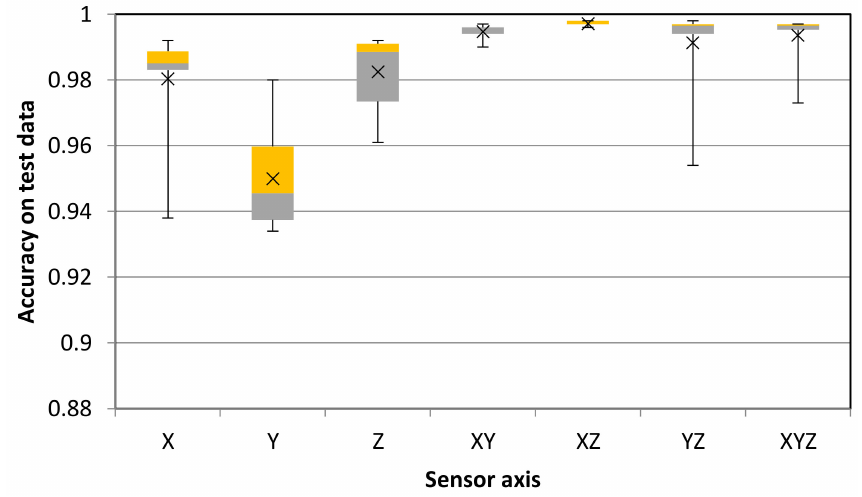
Figure 27. Box plot of ‘accuracy on test data’ for all sensor axis of the